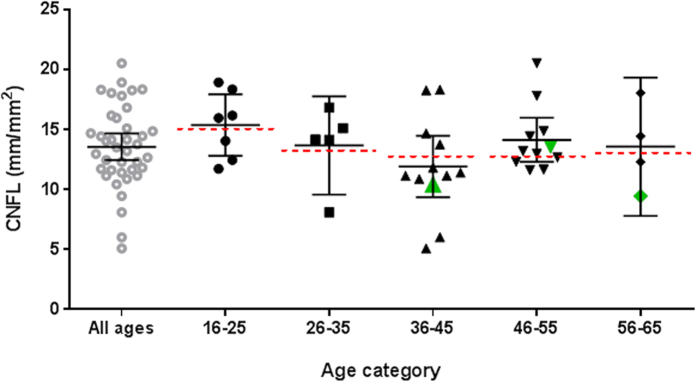
Cornea nerve fiber length (CNFL) individual data (with average and 95% confidence interval) compared to female reference values per age category19.The dotted lines indicate the 0.05 percentile normative cutoff values for decreased CNFL. The green data points mark male fibromyalgia patients; only the CNFL of the male in age category 46–55 was not significantly decreased compared to the male reference value (not shown) in the corresponding age category.